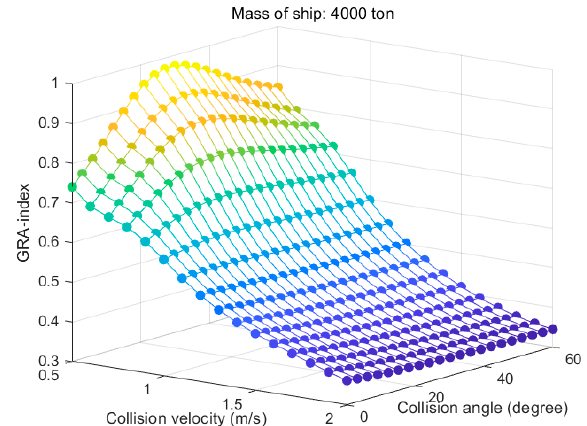
Figure 13. GRA index with regard to collision velocity and collision angle.